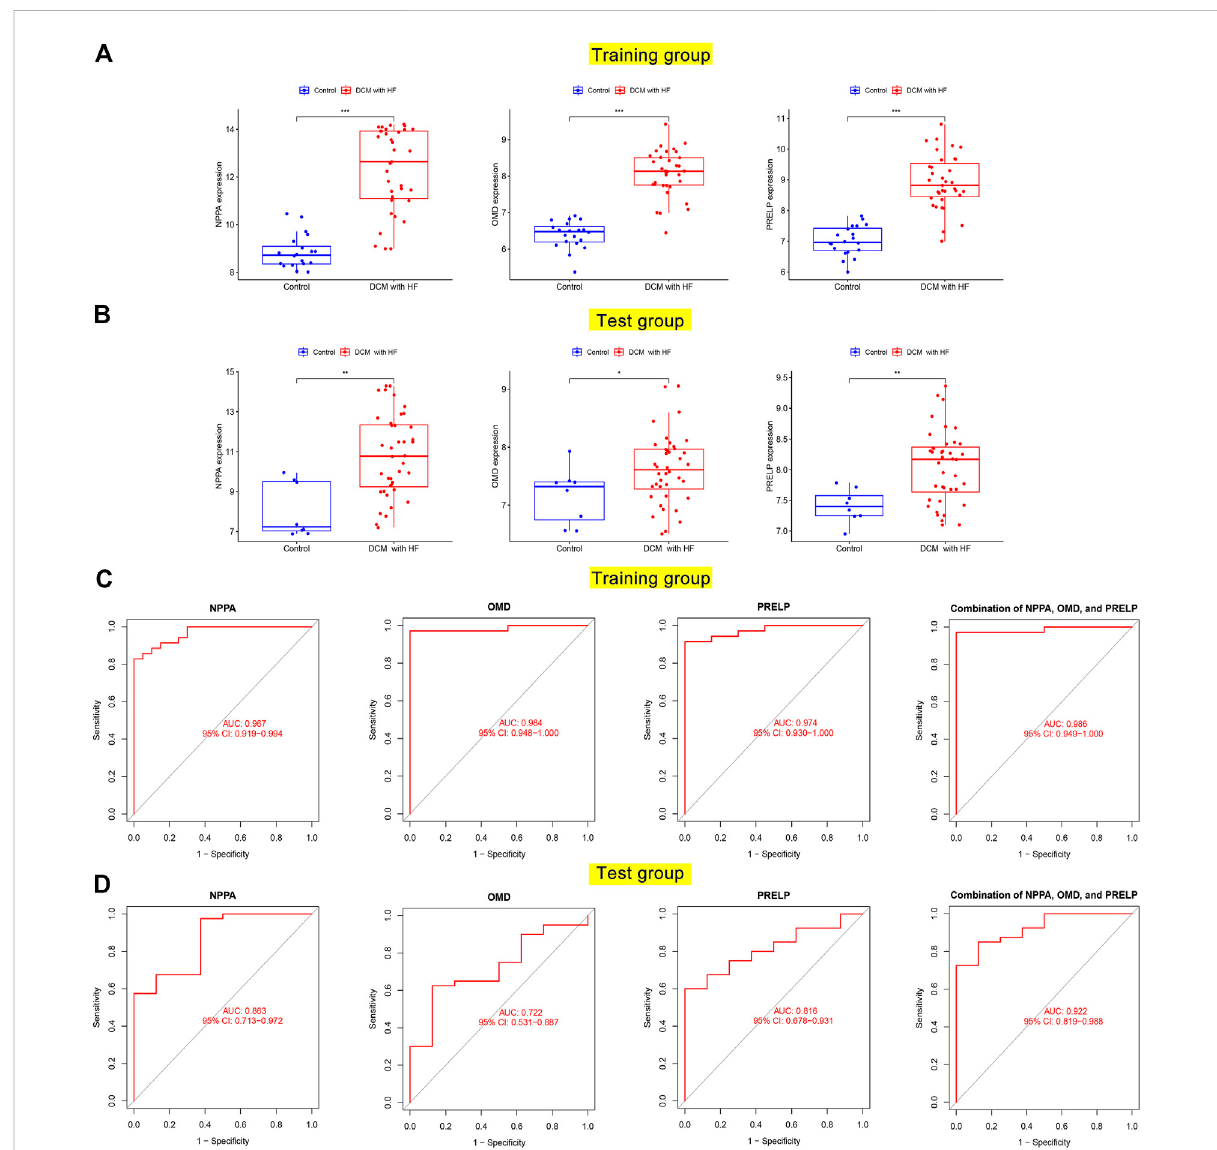
FIGURE 7 Differential expression and diagnostic accuracy of key genes in the training and test groups. The mRNA expression levels of NPPA, OMD, and PRELPbetweennormalheartsanddamagedheartsofDCMwithHFinthetraininggroup (A) andtestgroup (B) .ROCcurvesforevaluatingdiagnostic accuracy of NPPA, OMD, and PRELP in the training group (C) and test group (D)